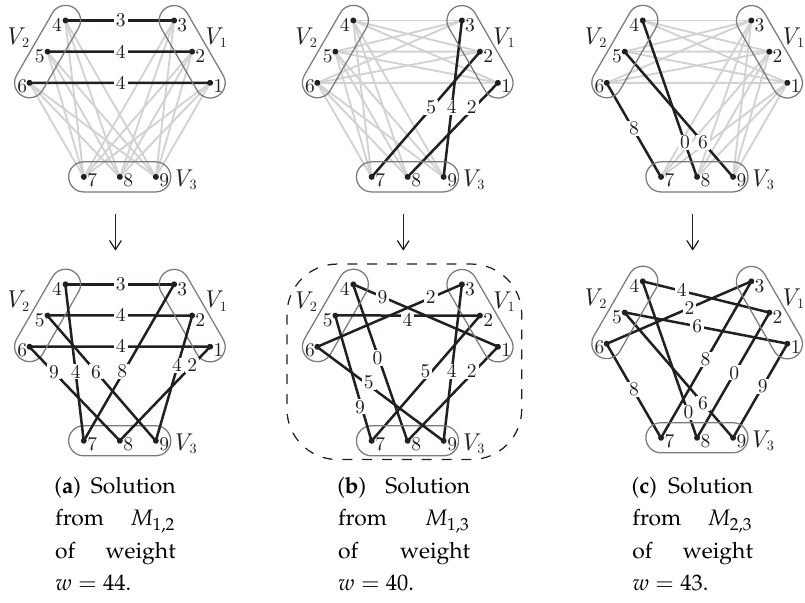
Figure 2. Cases for Algorithm B M